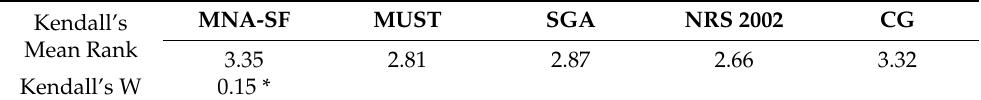
Table 4. Mean rank of each nutritional tool assessment for nutritional risk/malnutrition identification.